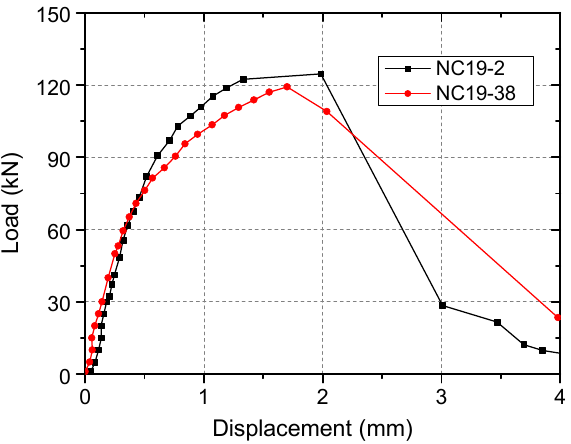
Figure 4. Load–displacement curves of specimens. Table 2. Experimental results.